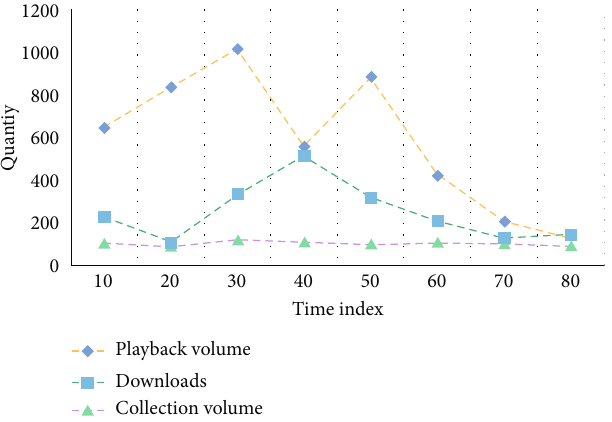
Figure 3: Average number of songs played, downloaded, and collected by singers.